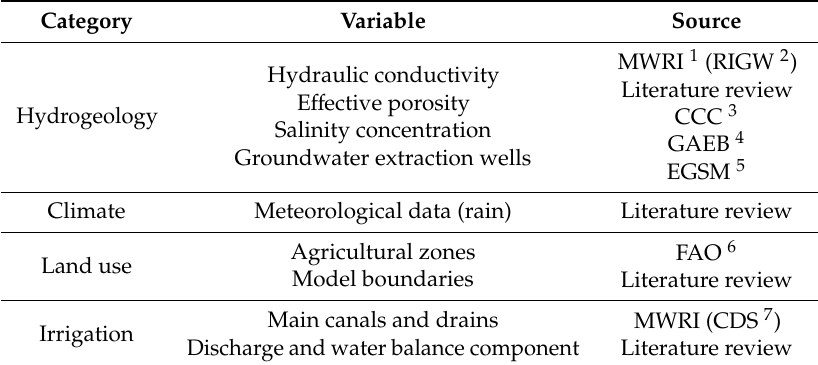
Table 1. An overview of main data sets and its